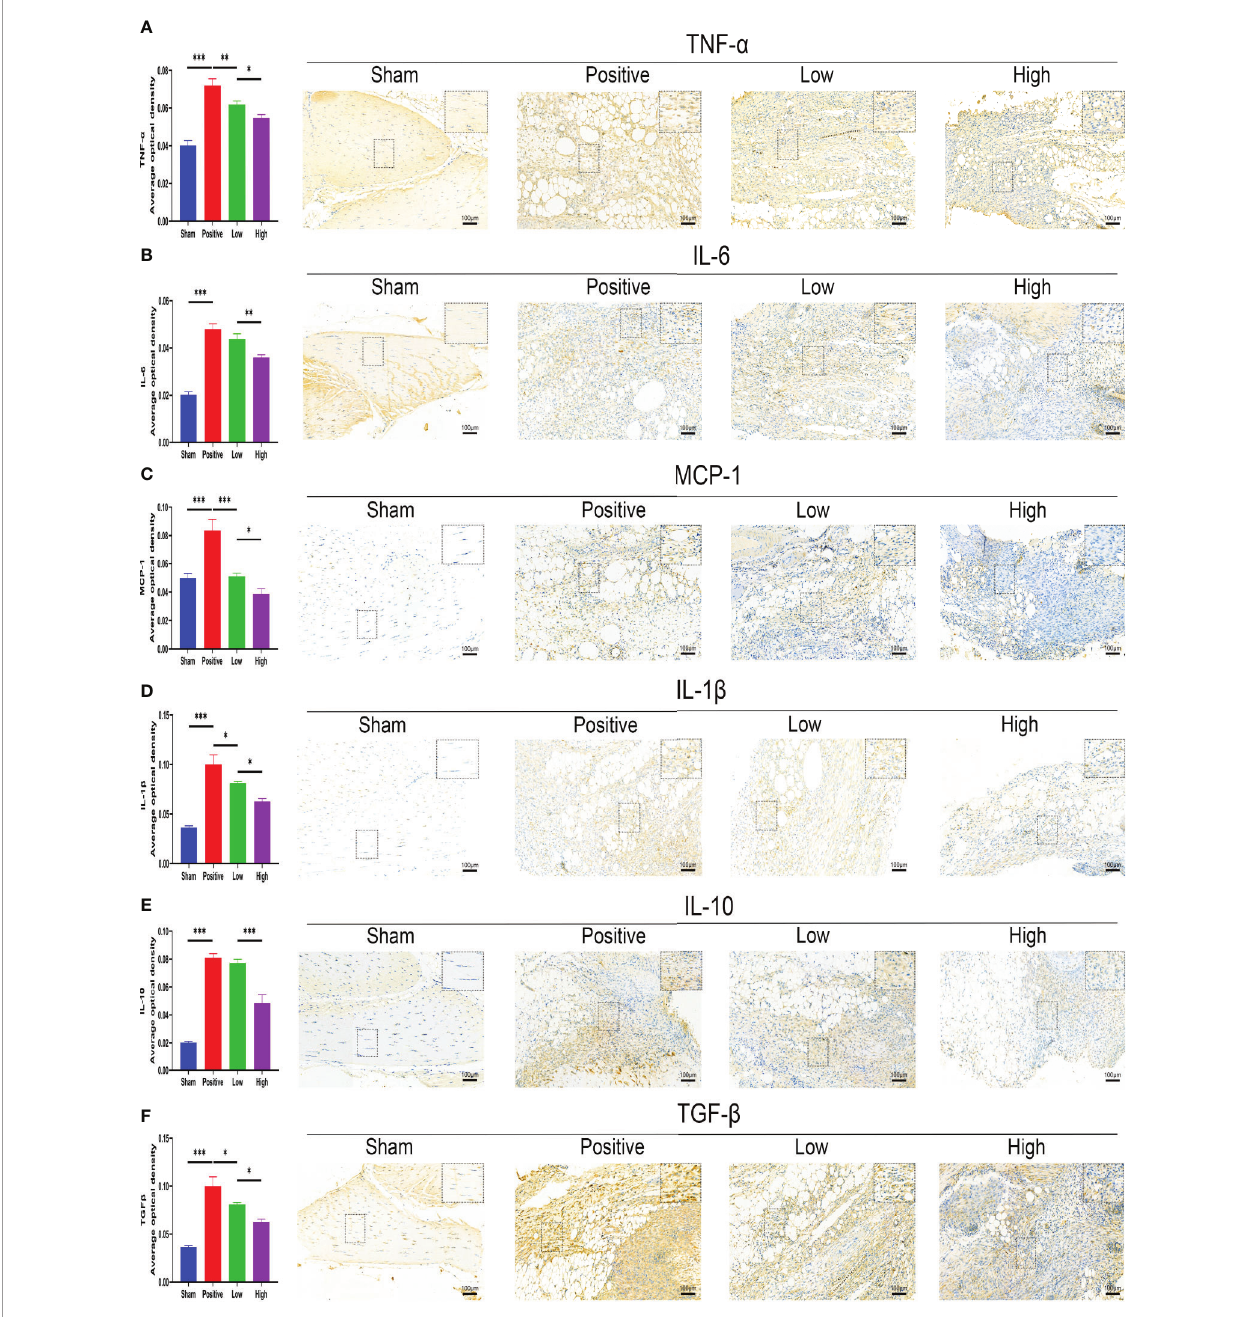
FIGURE 8 | Quercetin relieved in fl ammatory mediator accumulation after tendon injury in a dose-dependent manner. Immunohistochemical staining and quanti fi cation of (A) TNF- a , (B) IL-6, (C) MCP-1, (D) IL-1 b , (E) IL-10, and (F) TGF- b in tissue sections 7 days after burn/tenotomy. The average optical density was calculated using Image-Pro Plus software. Original magni fi cation is 20x. Inserts are approximately 3.5x magni fi ed images of the boxed area. N=4/group. *P < 0.05, **P < 0.01, ***P <